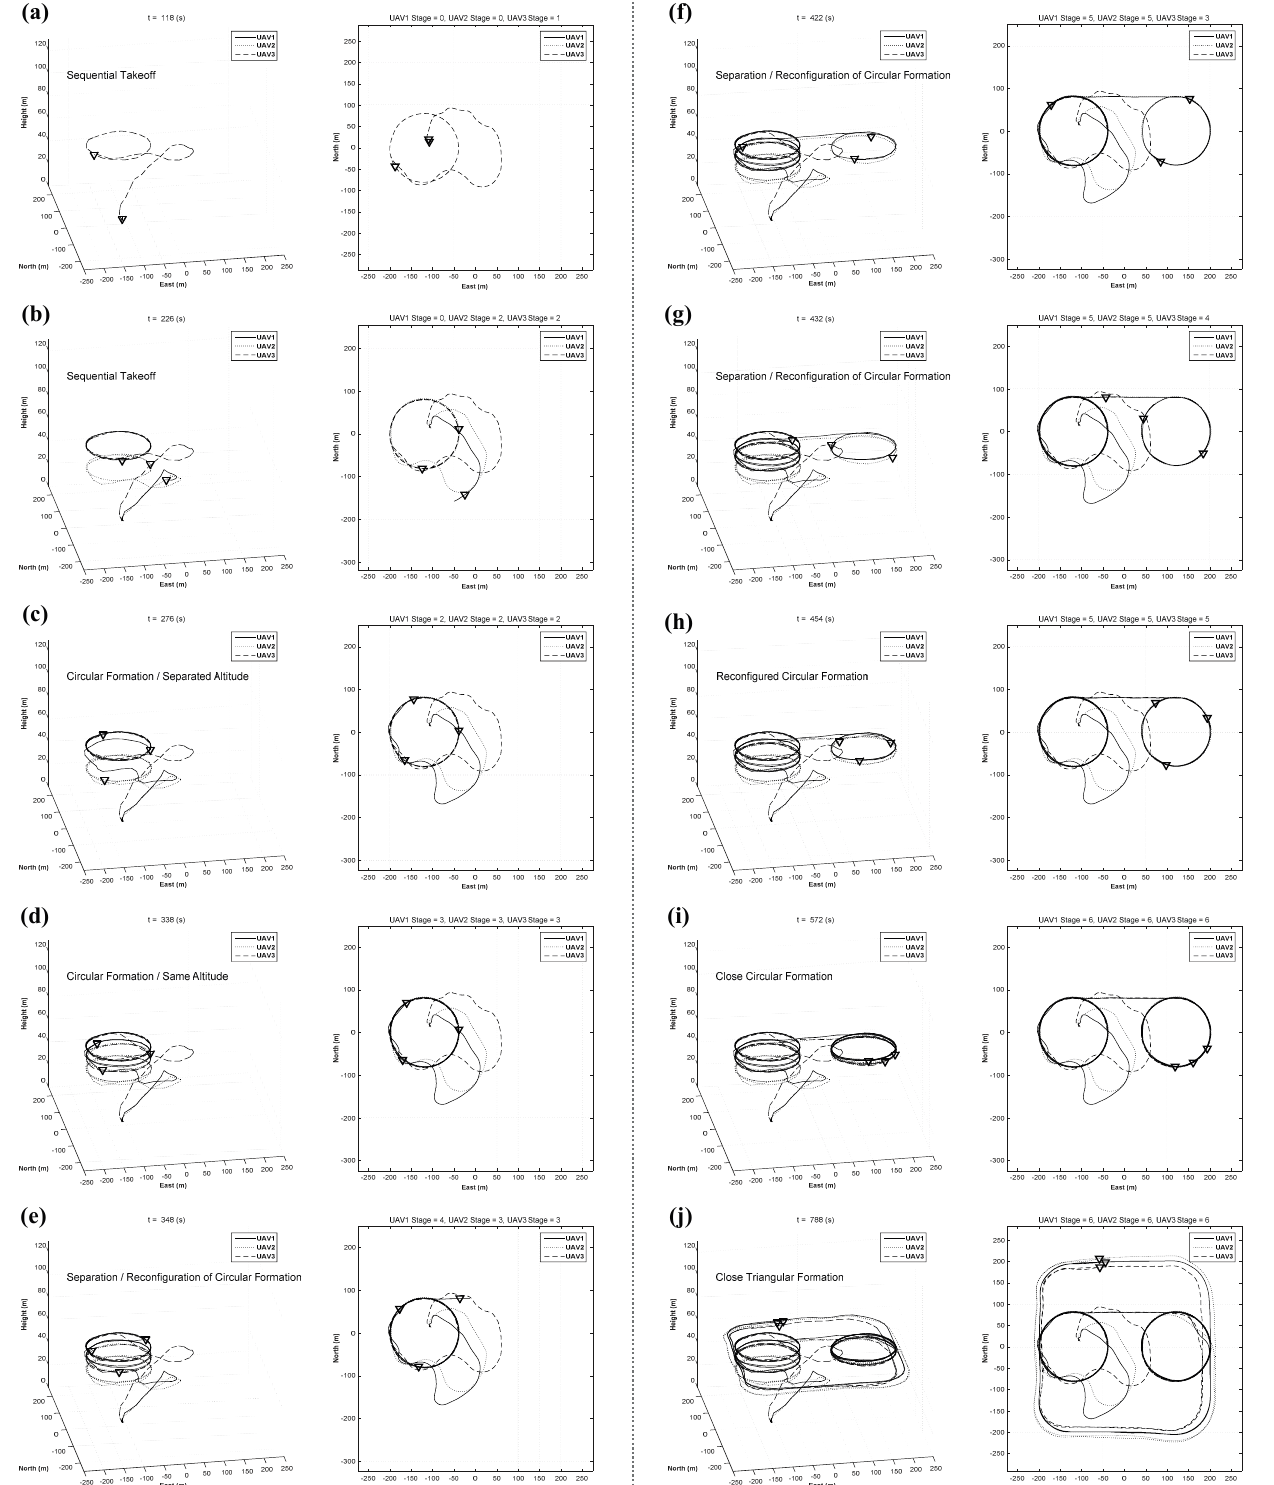
Figure 15. Flight results of integrated formation flight: ( a )–( b ) sequential takeoff; ( c ) circular formation at different altitudes; ( d ) circular formation at same altitude; ( e )–( h ) separation and reconfiguration of circular formation; ( i ) close circular formation; ( j ) close triangular